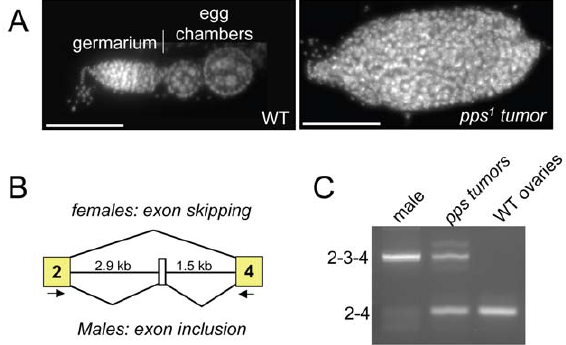
Figure 2. Sxl splicing is disrupted in the ovaries of incompletely rescued pps 1 mutant females. (A) DAPI-stained ovariole from a wild female (WT) and a P{pps + }/ + ; pps 1 /Df(3R)Exel7316 female. (B) Diagram of the alternative splicing event that produces sex-specific Sxl transcripts. The arrows below the diagram indicate the position of the PCR primer pairs used for RT–PCR. (C) The tumor phenotype is correlated with Sxl splicing defects. Splicing was assayed by RT–PCR using RNA isolated from ovaries dissected from P{pps + }/ + ; pps 1 /Df(3R)Exel7316 females ( pps tumors). Controls include splicing in ovaries isolated from wild type (WT) females and splicing in adult